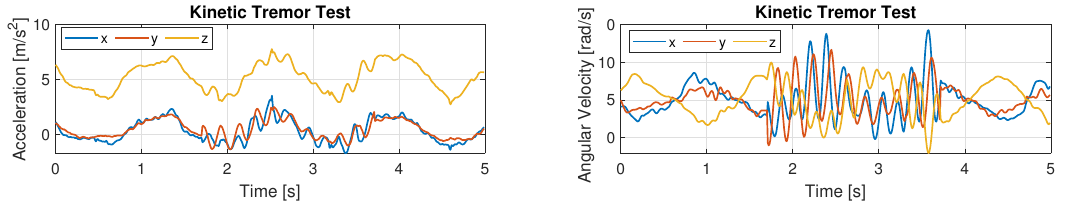
Figure 8. Simulated pathological data: acceleration data on the left; angular velocity data for the same tests on the